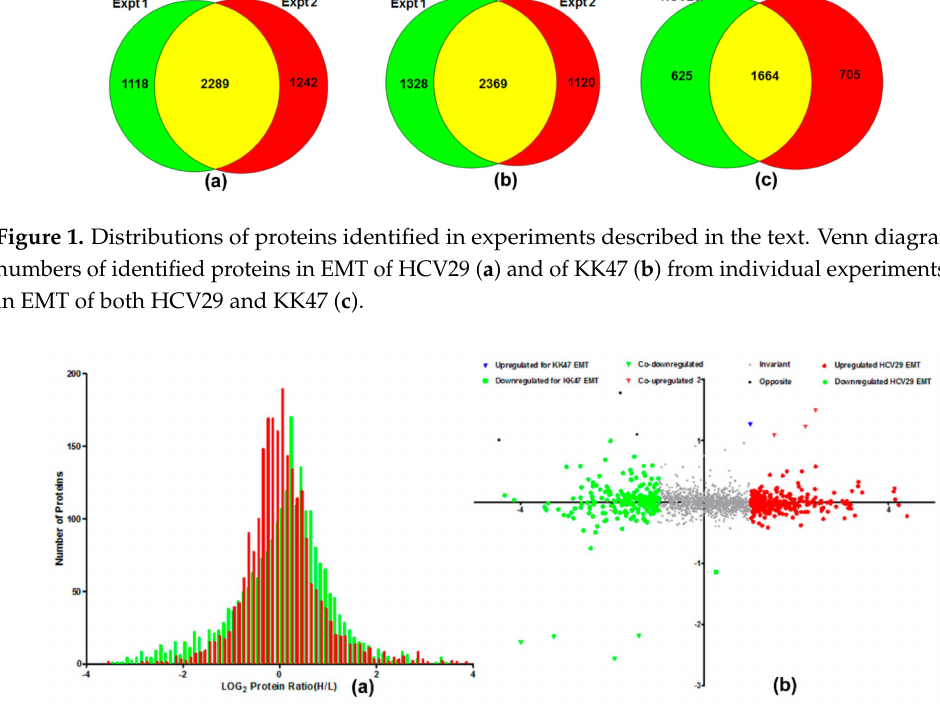
Figure 2. Distribution of SILAC H/L ratios in EMT of HCV29 and KK47 cells. ( a ) Distribution of SILAC H/L ratios; ( b ) Ratios of EMT in HCV29/HCV29 (H/L) and in KK47/KK47 (H/L) for the set of 1664 proteins. log 2 of the SILAC ratio for each protein ( n = 2) reflects difference in relative expression in EMT of HCV29 and KK47.